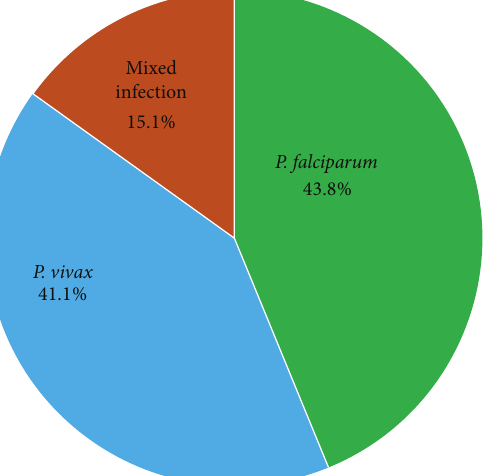
Figure 1: Frequency of malaria among febrile patients at Ayinba Health Center Northwest Ethiopia, April to May 2013.